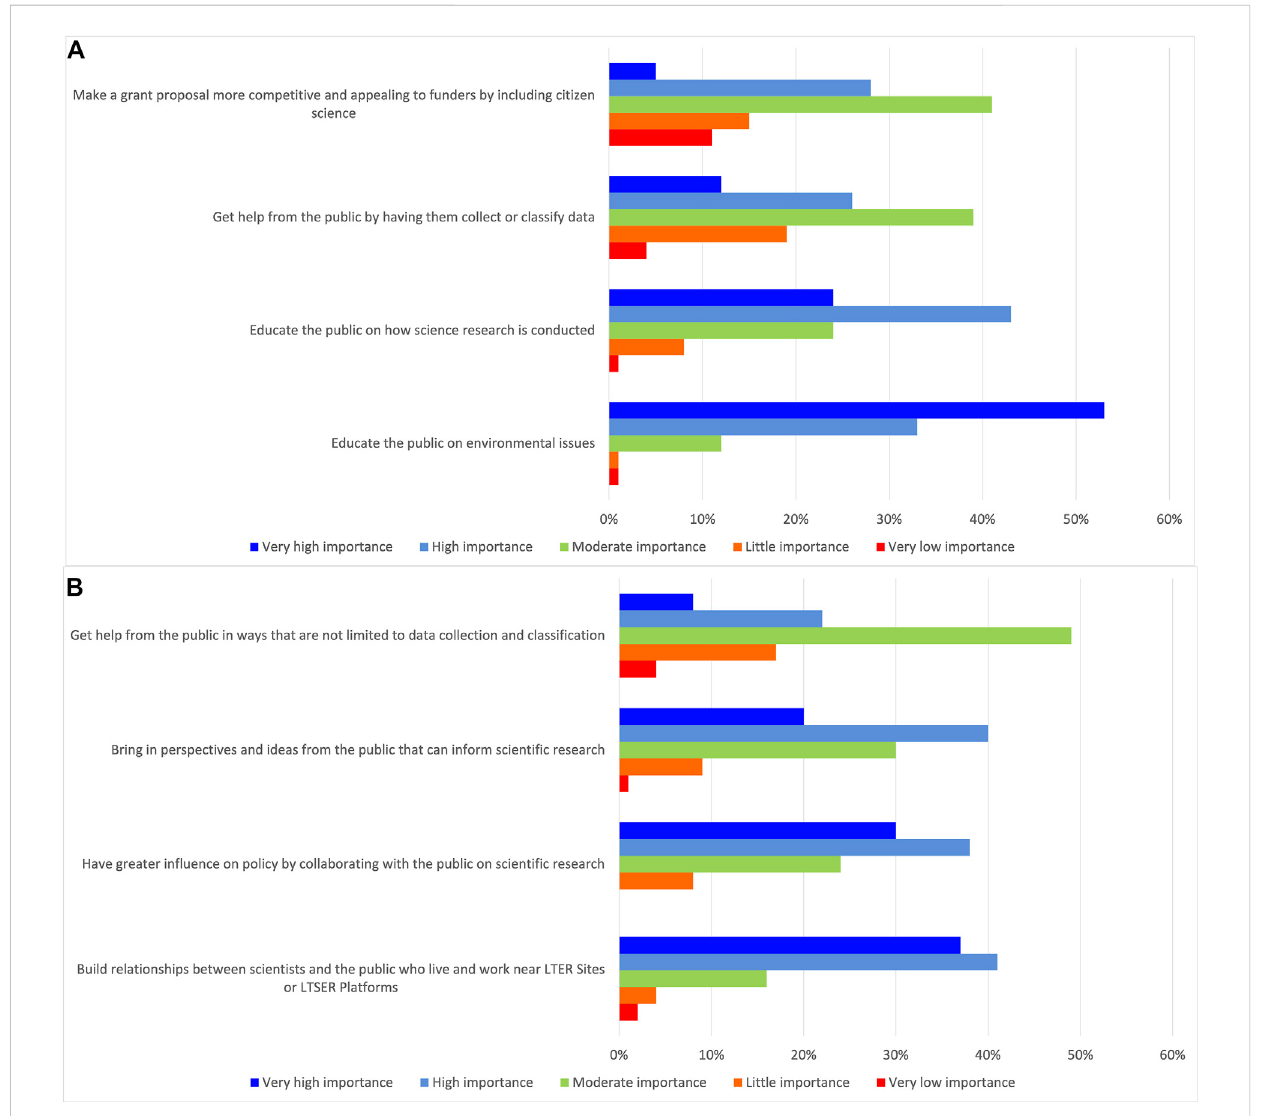
FIGURE 3 Percentage of respondents who rated the importance of different reasons for participation in CS. (A) traditional reasons; (B) expanded